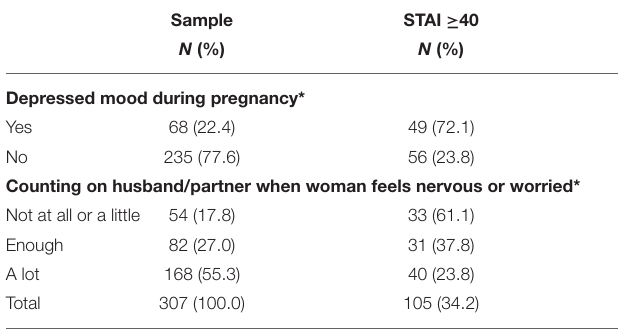
TABLE 1 | Characteristics of the sample and prevalence of current postnatal